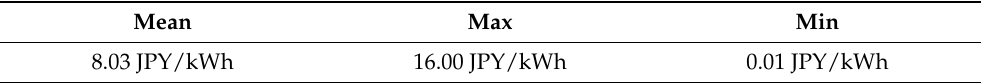
Table 10. Mean, maximum, and minimum values of bid-ask spreads (with the flexible market